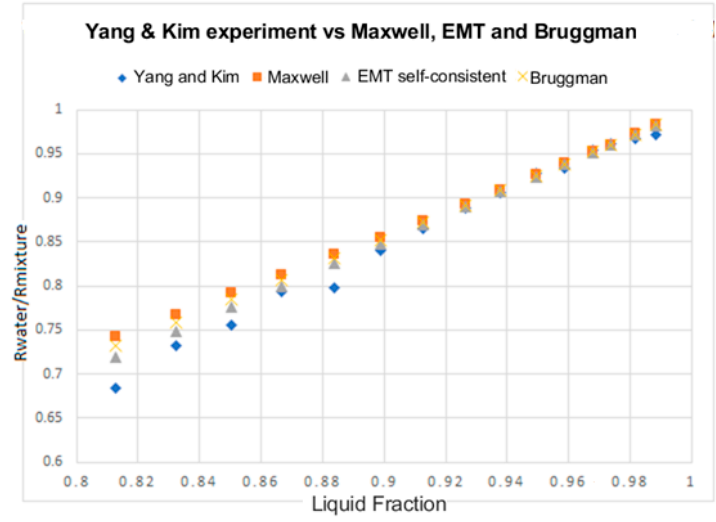
(cid:3415) ), versus liquid fraction for probe II, of Yang Figure 13. Non-dimensional resistance ratio ( R w ), versus liquid fraction for probe II, of Yang and Figure 13. Non-dimensional resistance ratio ( (cid:1844) (cid:3050) (cid:1844) R mixture (cid:3040)(cid:3036)(cid:3051)(cid:3047)(cid:3048)(cid:3045)(cid:3032) Kim experiments [21], and comparison with Maxwell results (squares), EMT self- consistent (triangles), and Bruggeman (Saint Andrew